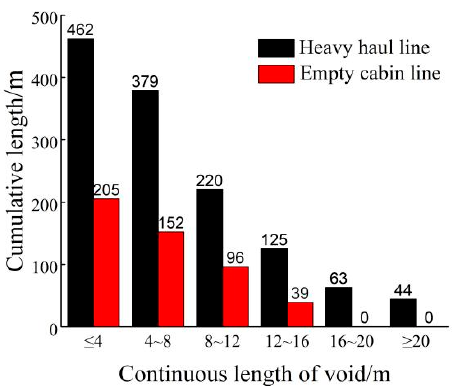
Figure 2. Cumulative length of tunnel with different base void lengths.